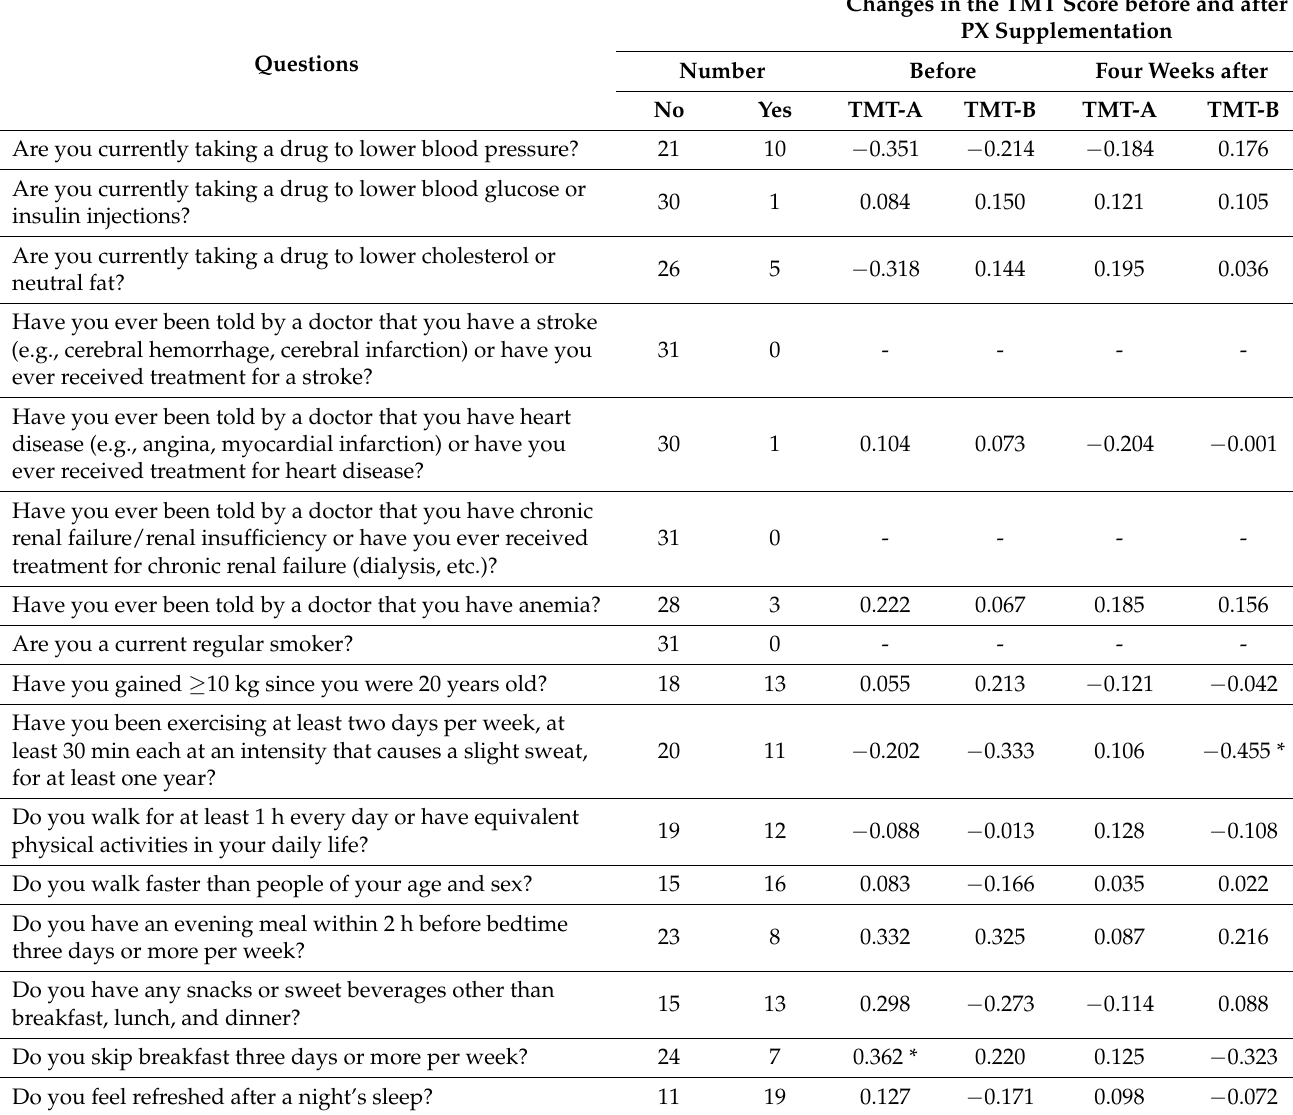
Table 2. Correlation between lifestyle and changes in the TMT